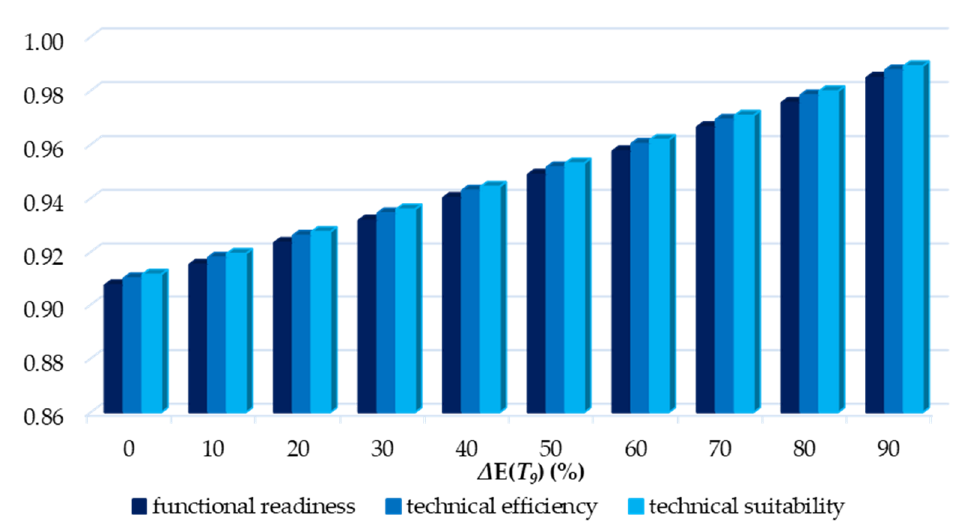
19 of 25 Table 9. Indicators values obtained in sensitivity analysis of SMM. Δ E ( T 9 ) (%)